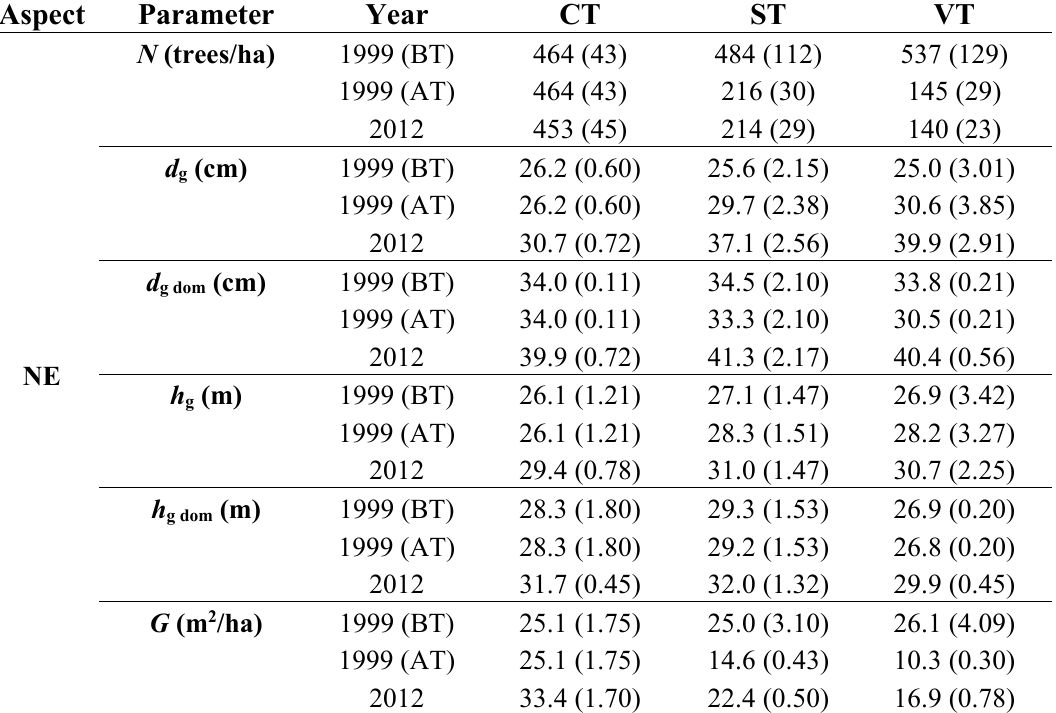
Table 2. Stand parameters—number of trees per hectare ( N ), quadratic mean diameter ( d g ), diameter of dominant trees ( d g dom ), height of the tree with mean basal area ( h g ), height of dominant trees ( h g dom ), stand basal area ( G ) and stand volume ( V ) with standard deviation before and after the thinning (BT, AT) and at the end of the analyzed period for all treatments, control (CT), strong thinning (ST), and very strong thinning